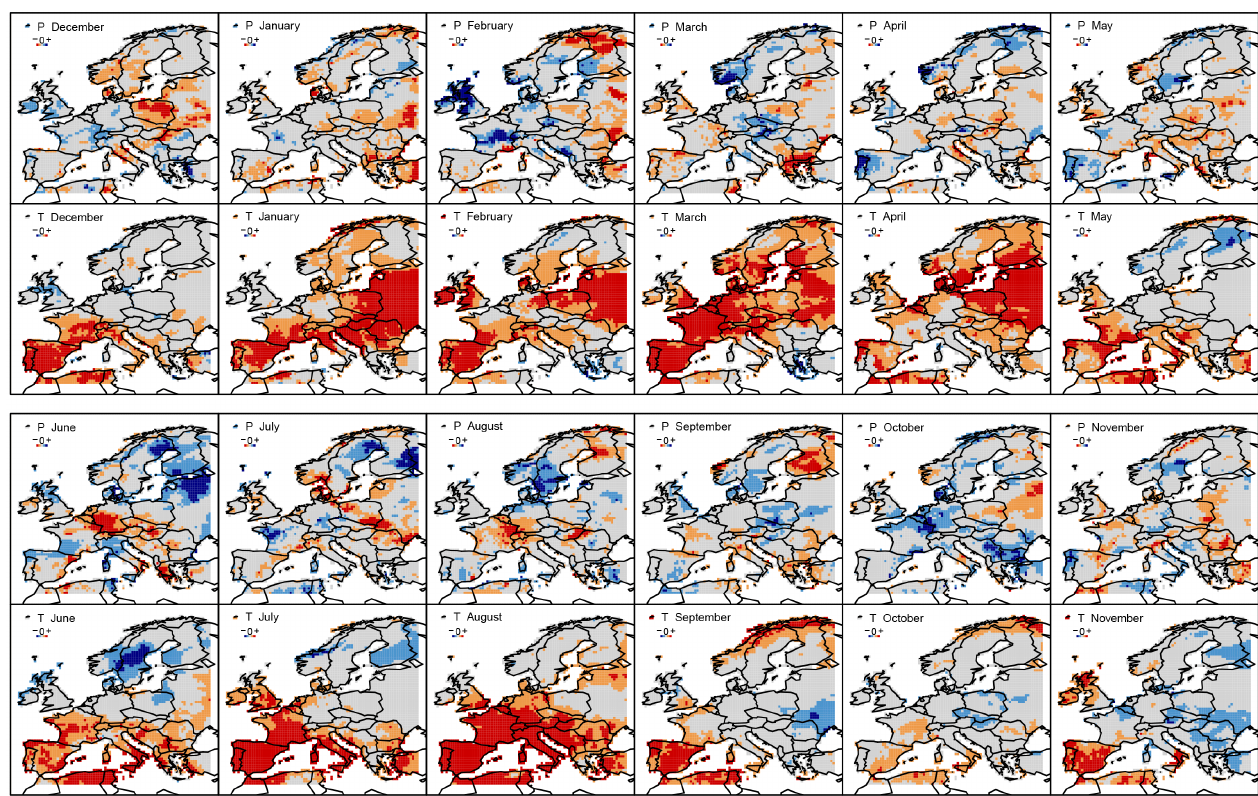
Figure 5. Monthly trends within the groups of dry STs for precipitation (rows 1 and 3) and temperature (rows 2 and 4) significant at the 70% (light colours) and 95% (dark colours). Precipitation: increasing trends in blue, decreasing trends in red. Temperature: increasing trends in red, decreasing trends in